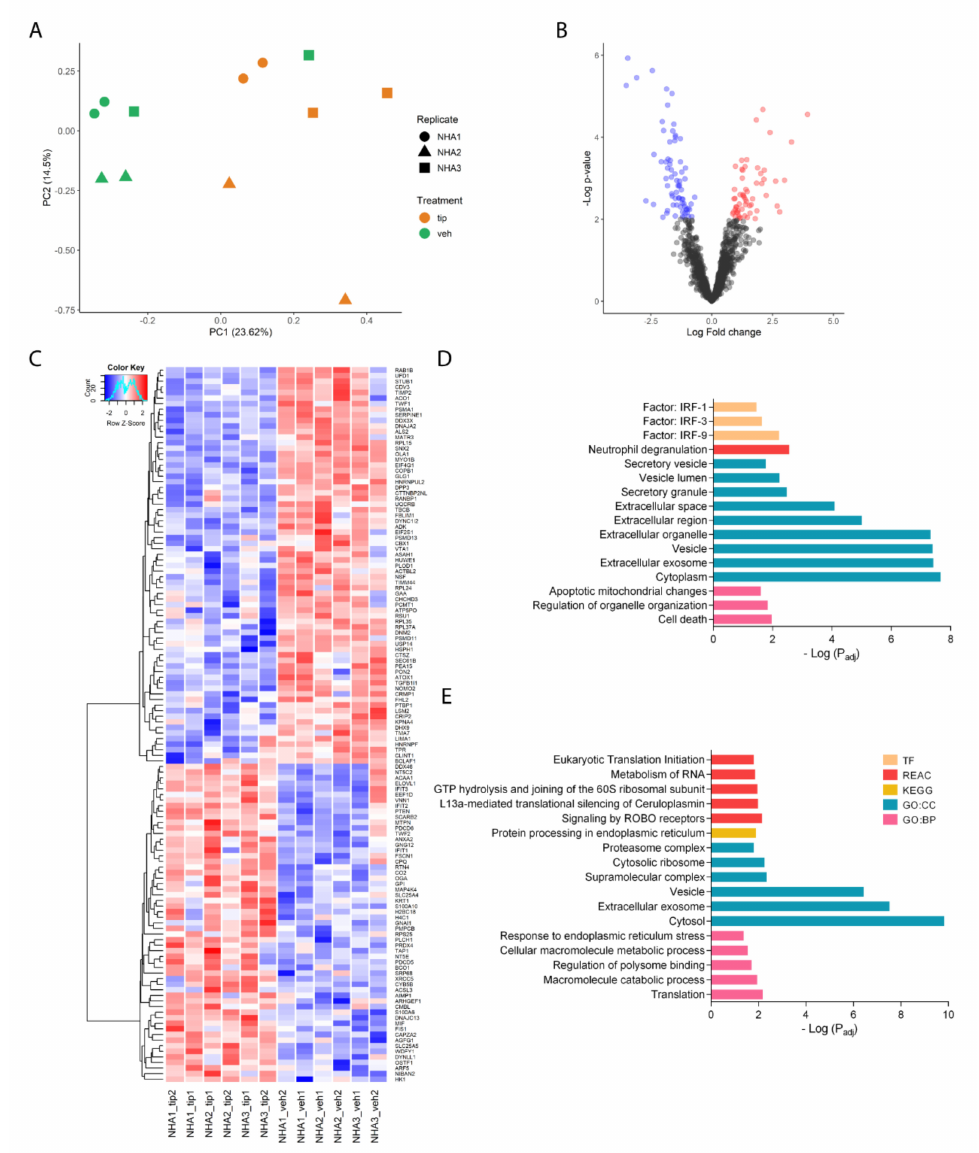
Figure 3. Differential expression of tip vs. veh. ( A ) PCA to evaluate the relationships between biological replicates and tip vs. veh treatments. ( B ) Volcano plot showing differentially expressed proteins with adjusted p -value < 0.01 and |Fold change| ≥ 1.5. ( C ) Heatmap of proteins differentially expressed proteins in tip vs. veh. Color scale: variation of normalized protein abundance (Z-Score). ( D ) Enrichment analysis of up-regulated proteins in tip vs. veh ( p < 0.05). ( E ) Enrichment analysis of down-regulated proteins in tip vs. veh ( p < 0.05). TF: TRANSFAC database; REAC: Reactome database; KEGG: Kyoto Encyclopedia of Genes and Genomes; GO:CC: Gene Ontology cellular component; GO: BP: Gene Ontology biological